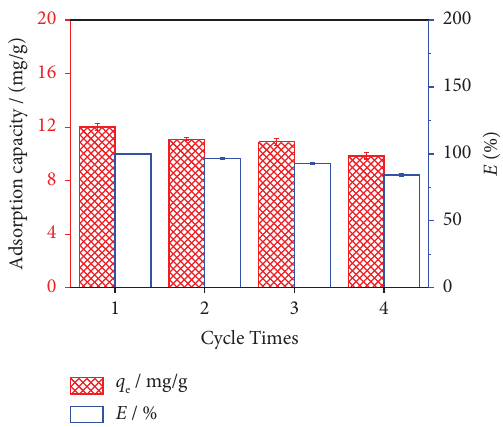
Figure 13: Regeneration performance of CMC-LTO-EGDE-ME for four-cycle times. Table 6: Comparison of the Li + adsorption capacity and equilibration time at the diferent initial contents and water samples. Adsorbent